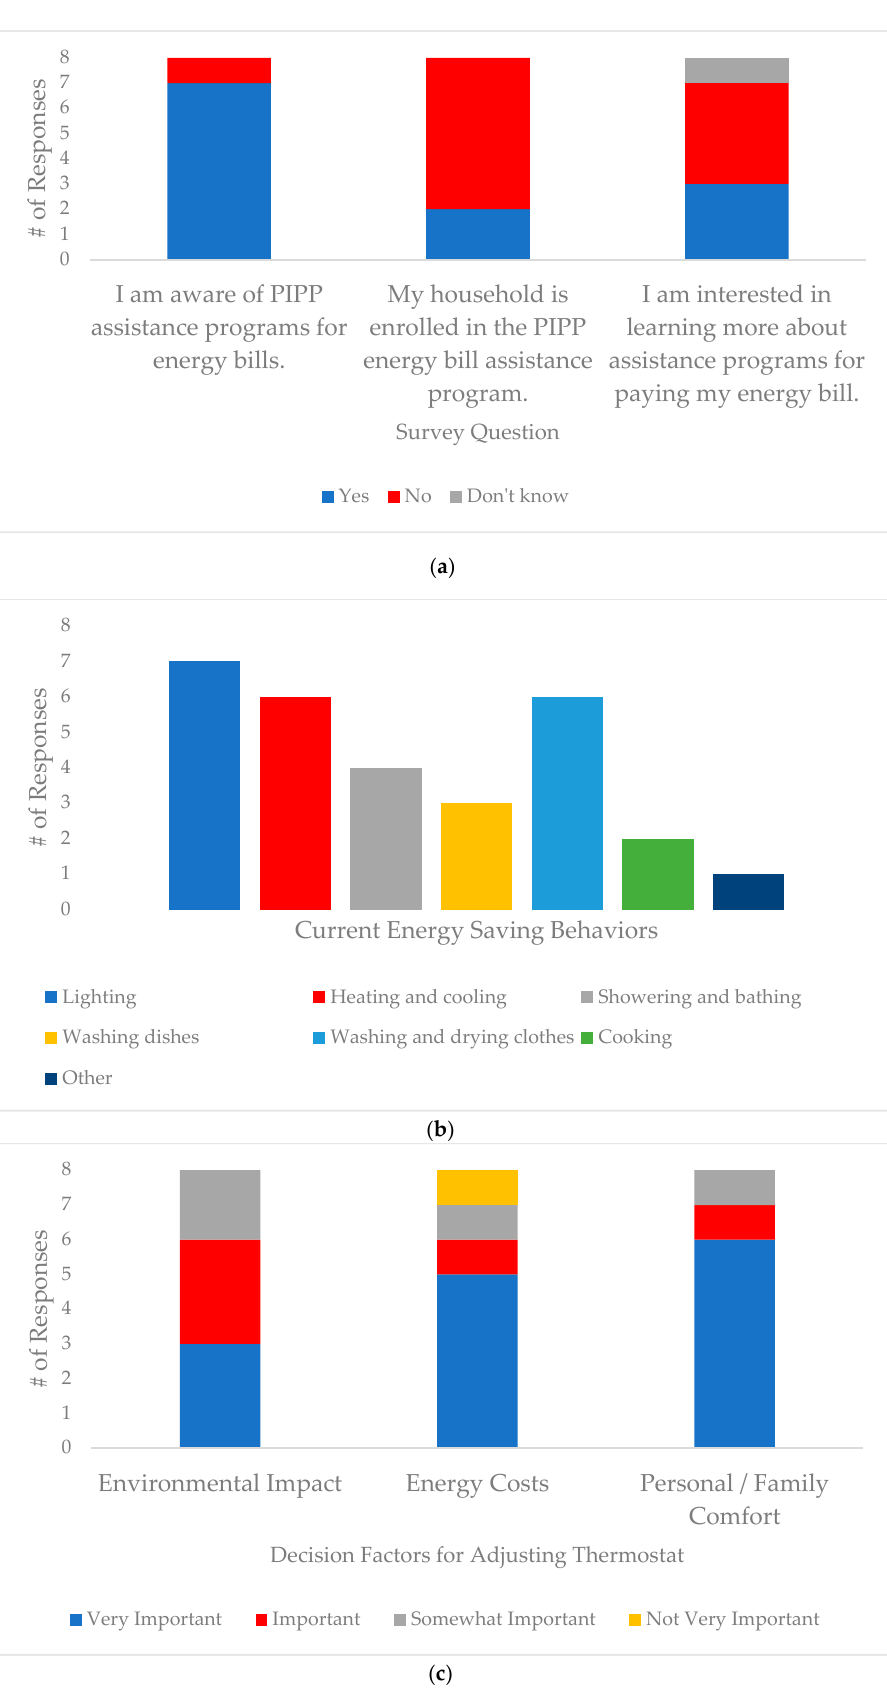
Figure 2. Participant survey results: ( a ) energy assistance programs; ( b ) energy behaviors; ( c ) thermostat motivators.